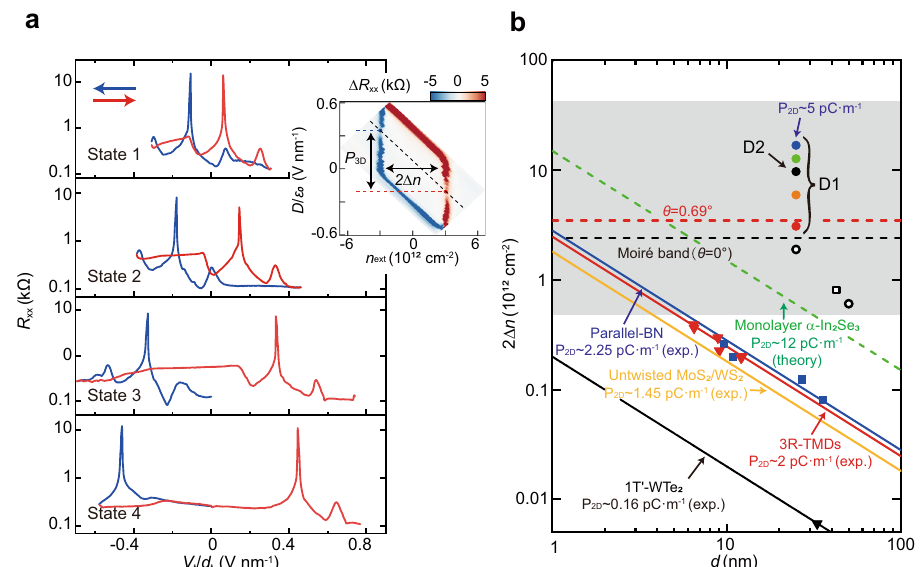
Fig. 3 | Enhanced charge polarization. a Four states with distinct magnitudes of hysteresis. Note the satellite peaks at FFP exhibit a constant shift from CNP in all states, indicating the moirésuperlattice keeps unchanged. The sweepingcurvesof State 2 is also denoted as the black cutting line in the inset, where the polarized charge Δ n and the internal electric dipole P 3D are also illustrated. b Summary of polarized charge densities in various ferroelectric systems. The 2 Δ n for D1 and D2 are depicted by fi lled circles, which are close to or well above the capability of typical moiré bands (the red dashed line: the twistedangleof0.69° asin D1).GSFE